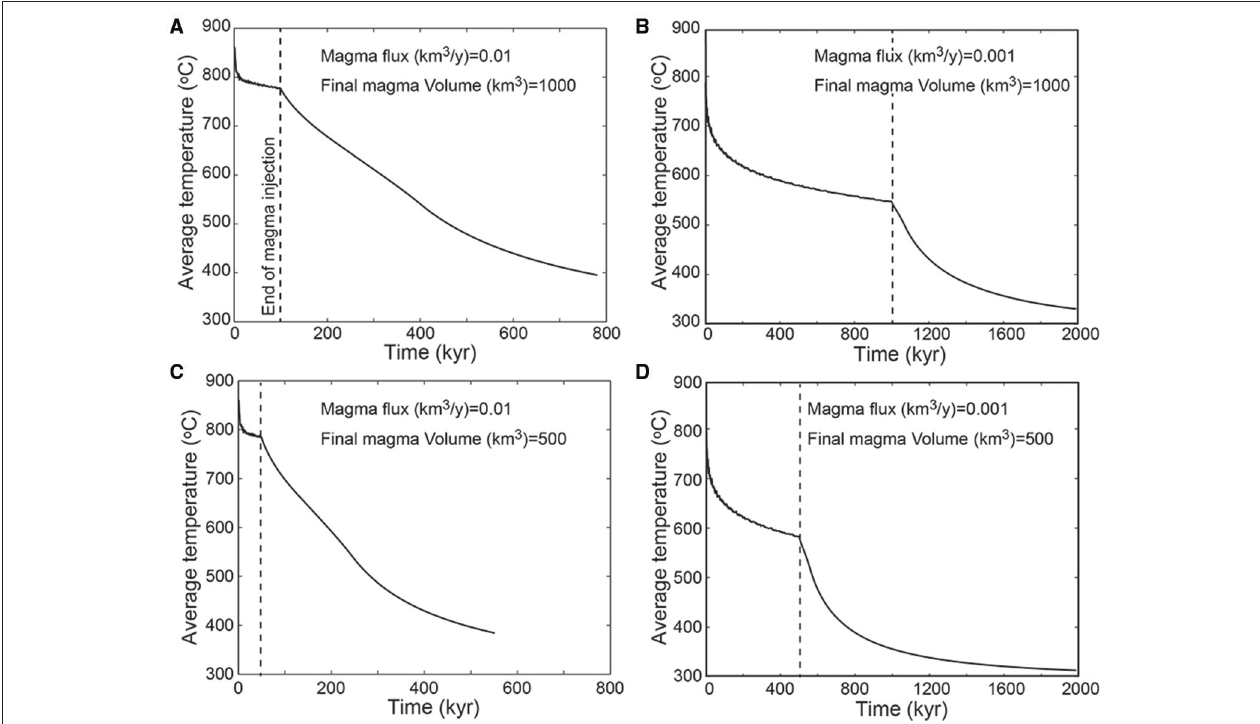
FIGURE 1 | Temporal evolution of the average intrusion temperature for thermal models performed at injection fluxes of 0.01 and 0.001 km 3 /y for (A,C) and (B,D),